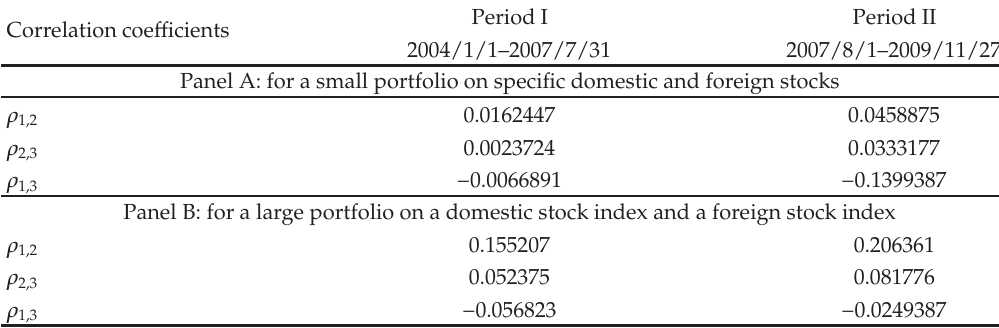
Table 3: Estimation of the correlation coe ffi cients in various